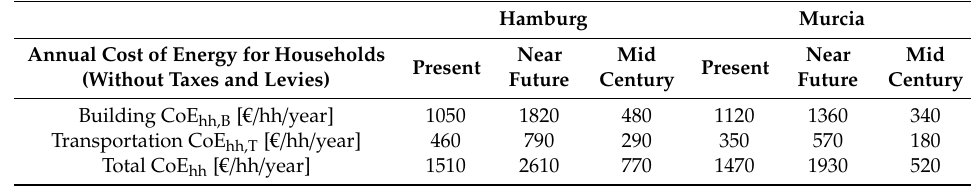
Table 5. The annual cost of energy for households (CoE hh ) without taxes and levies for the Present, Near Future, and Mid Century scenarios in Hamburg and